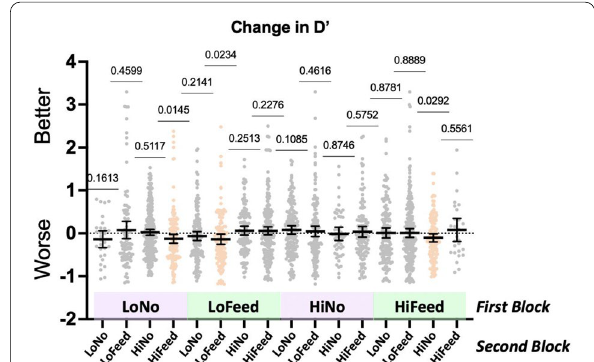
Fig. 4 Change in d ′ on block 2 as a function of the nature of block 1. p values show results for simple t -tests, testing against the null hypothesis that there is no change in d ′ . Black lines show means 95% confidence intervals ±